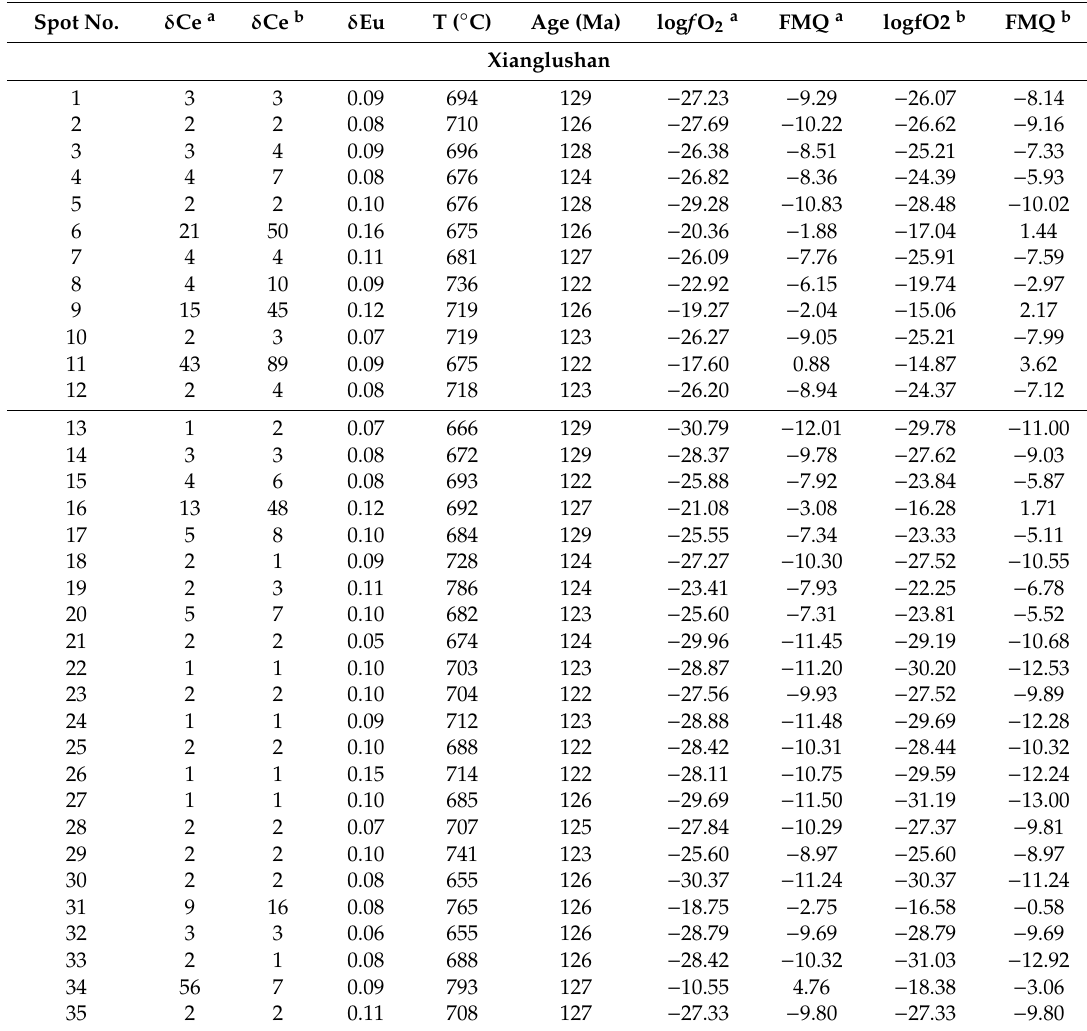
Table A1. Crystallization temperatures, Ce anomalies, and magma oxygen fugacity of zircon grains from the Xianglushan, Dahutang, and Xihuashan granites. Spot